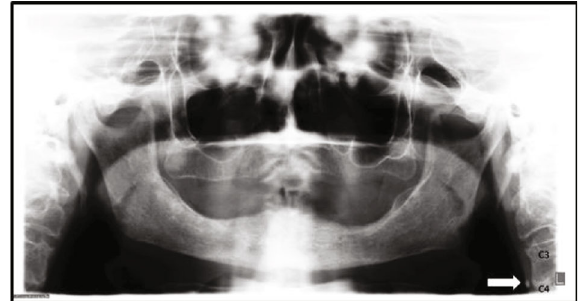
Figure 2: Panoramic radiograph showing radiopaque image circumscribed on the left side of the neck soft tissue region adjacent to the C3 and C4 intervertebral space (arrow).